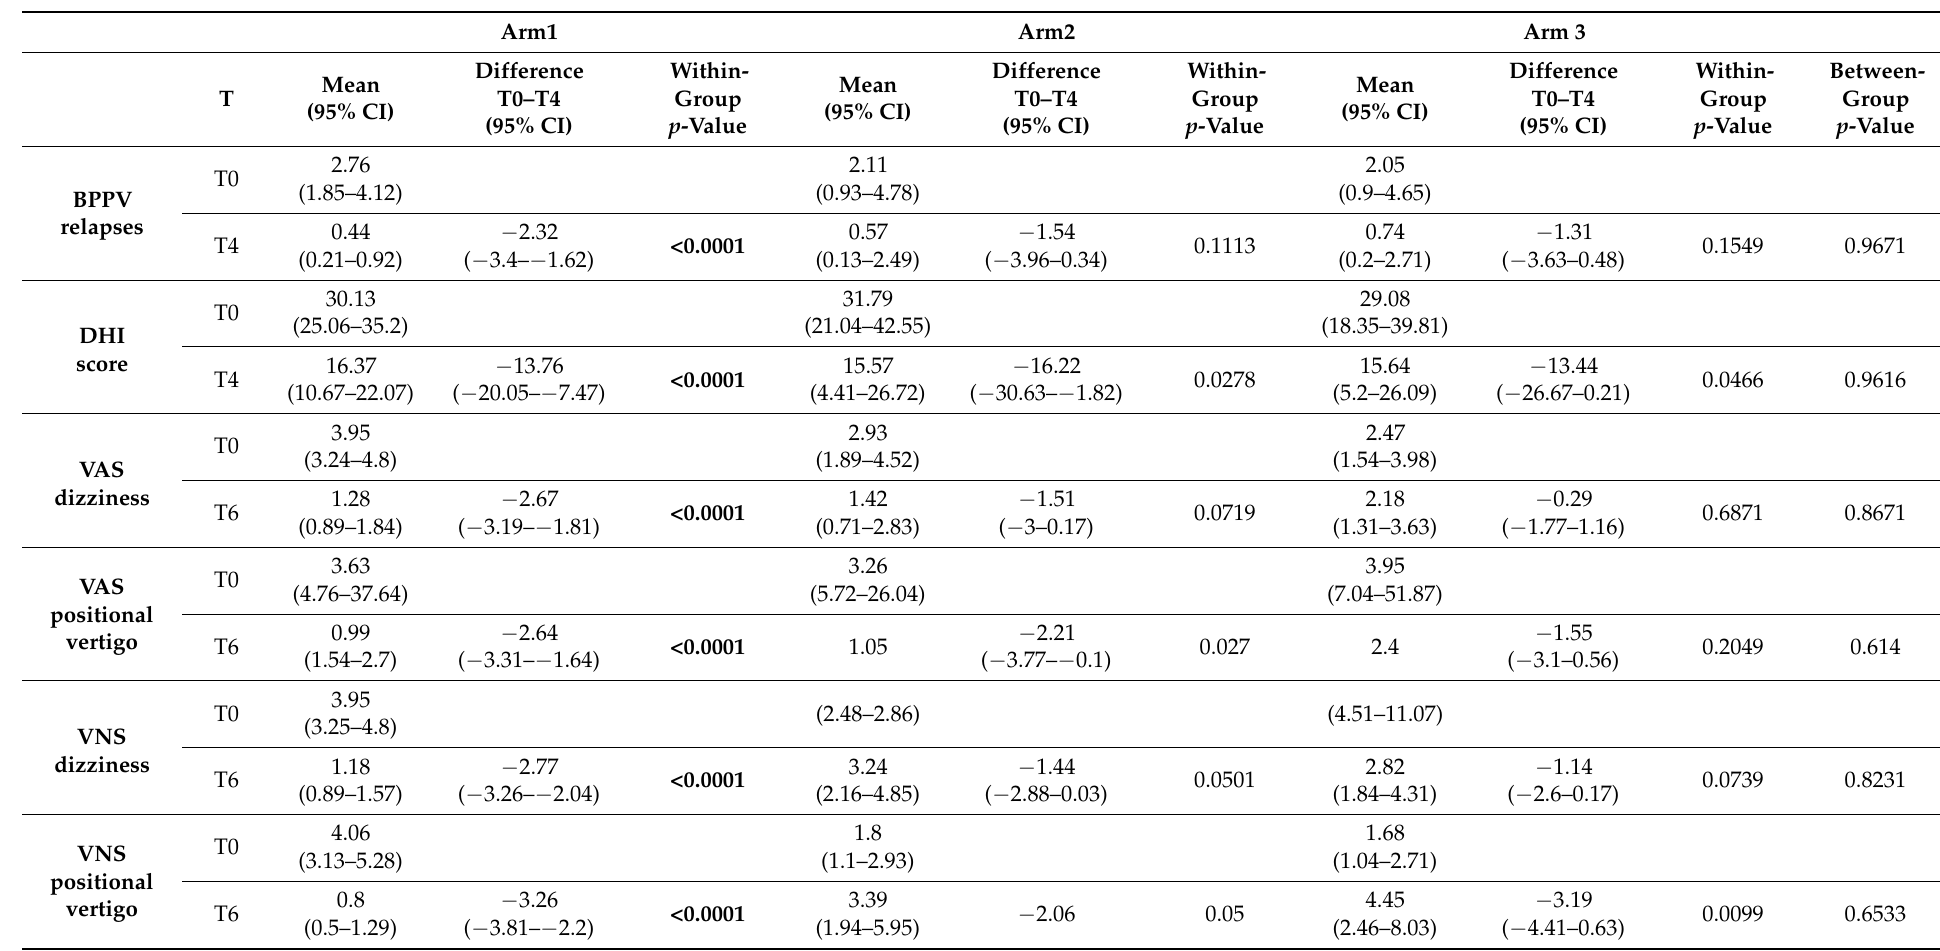
Table 3. Outcomes of ITT multivariate mixed model analysis. T1: randomization visit; T4: end of the